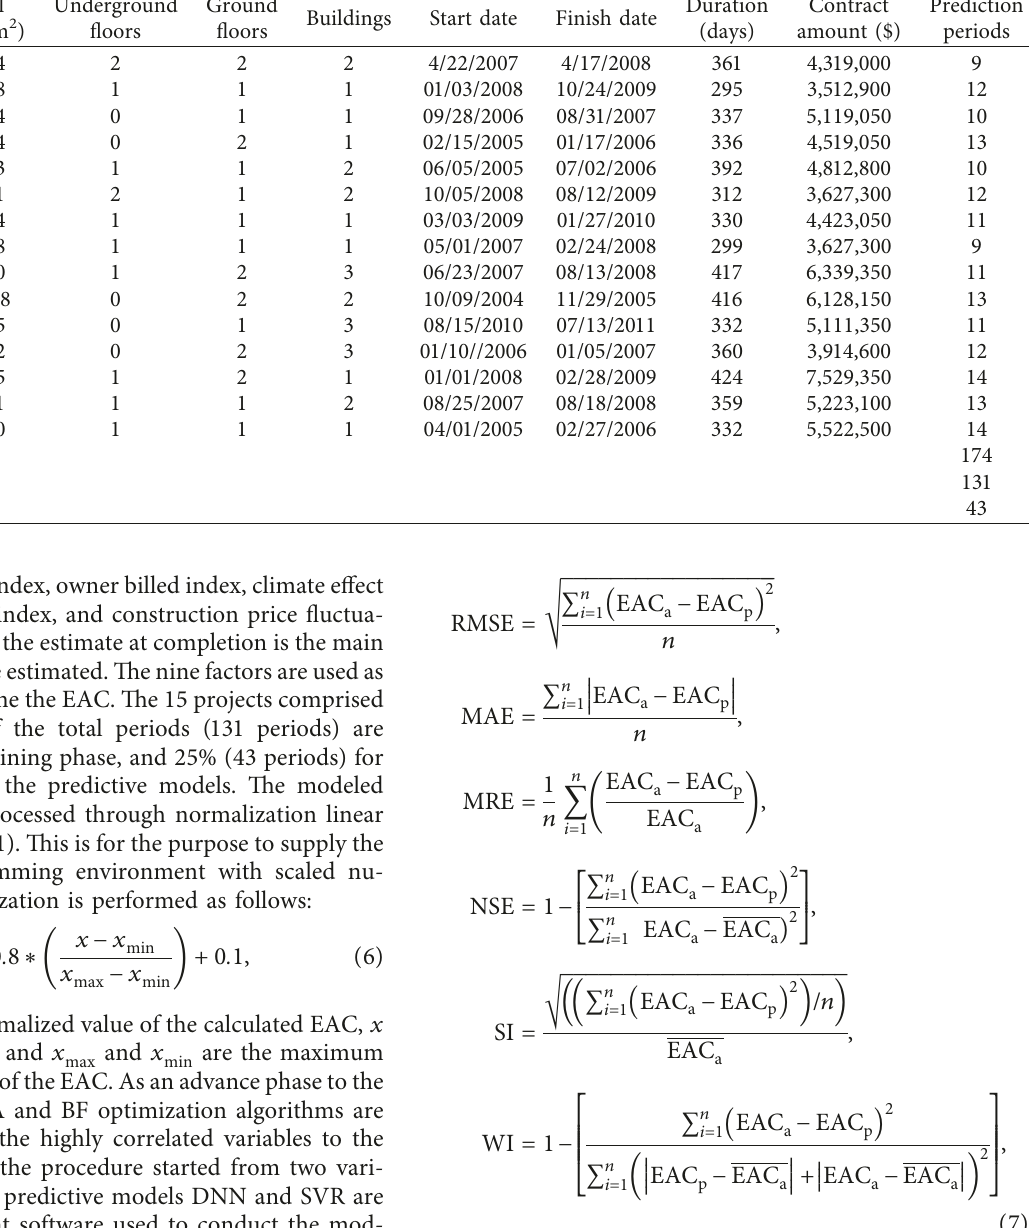
Table 1: The biodata of the inspected construction projections. Project